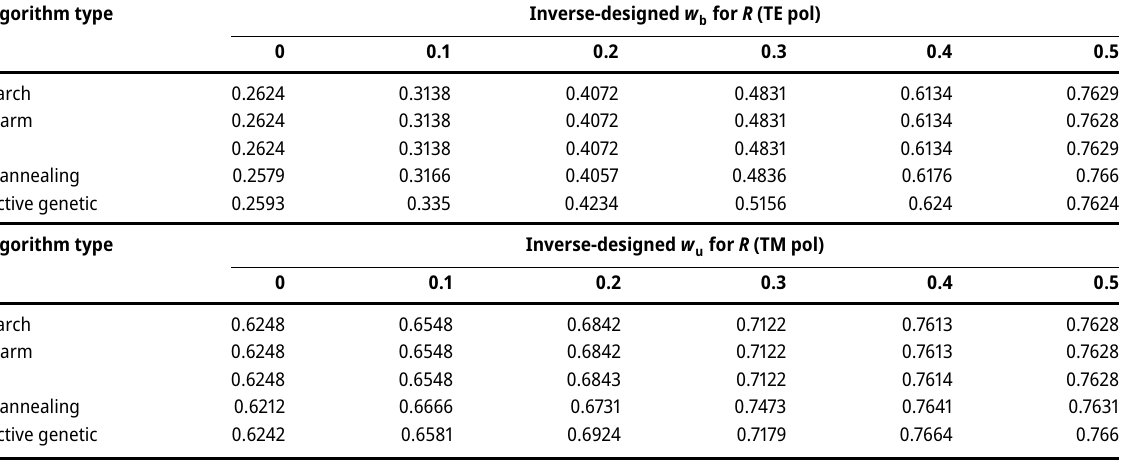
and the power splitting ratio for the TE polarization of